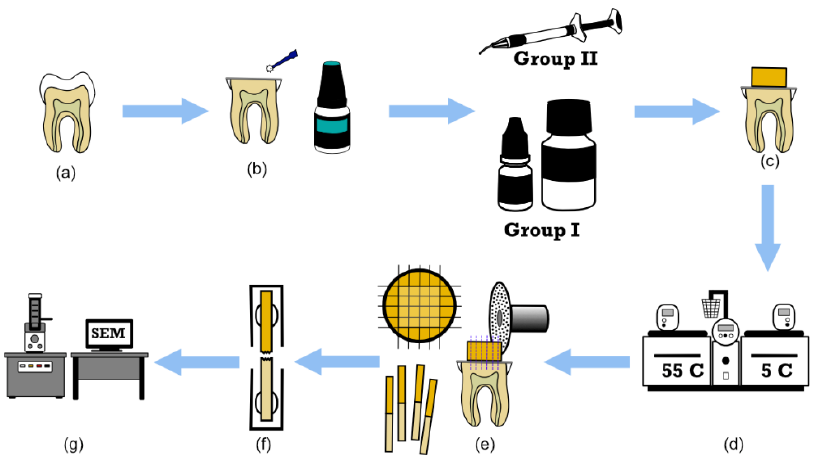
Figure 1. Schematic illustration of micro-tensile bond strength ( µ TBS). ( a ) Sound molars, ( b )